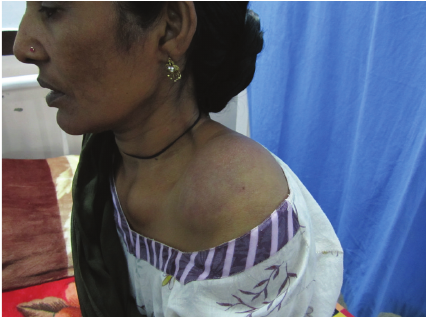
Figure 4: Patient with swellings subsided after 2 cycles of chemo-